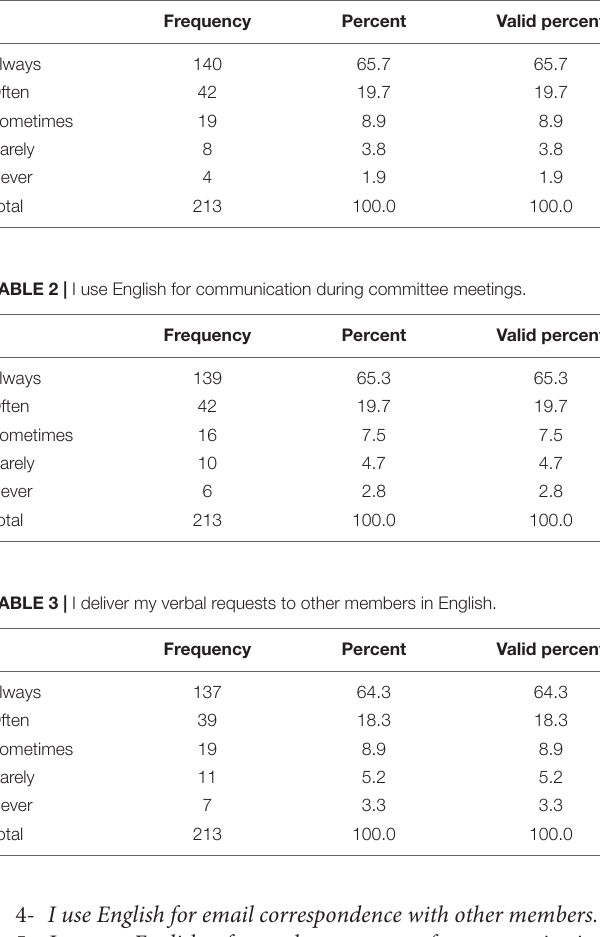
TABLE 1 | I use English for communication at department council meetings.